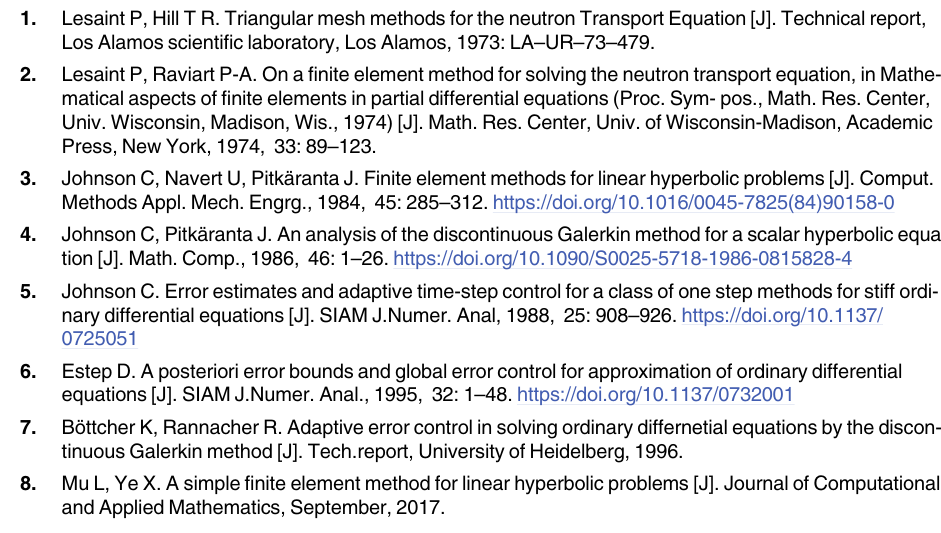
and error indicator η of the unit square mesh for experiment 6.